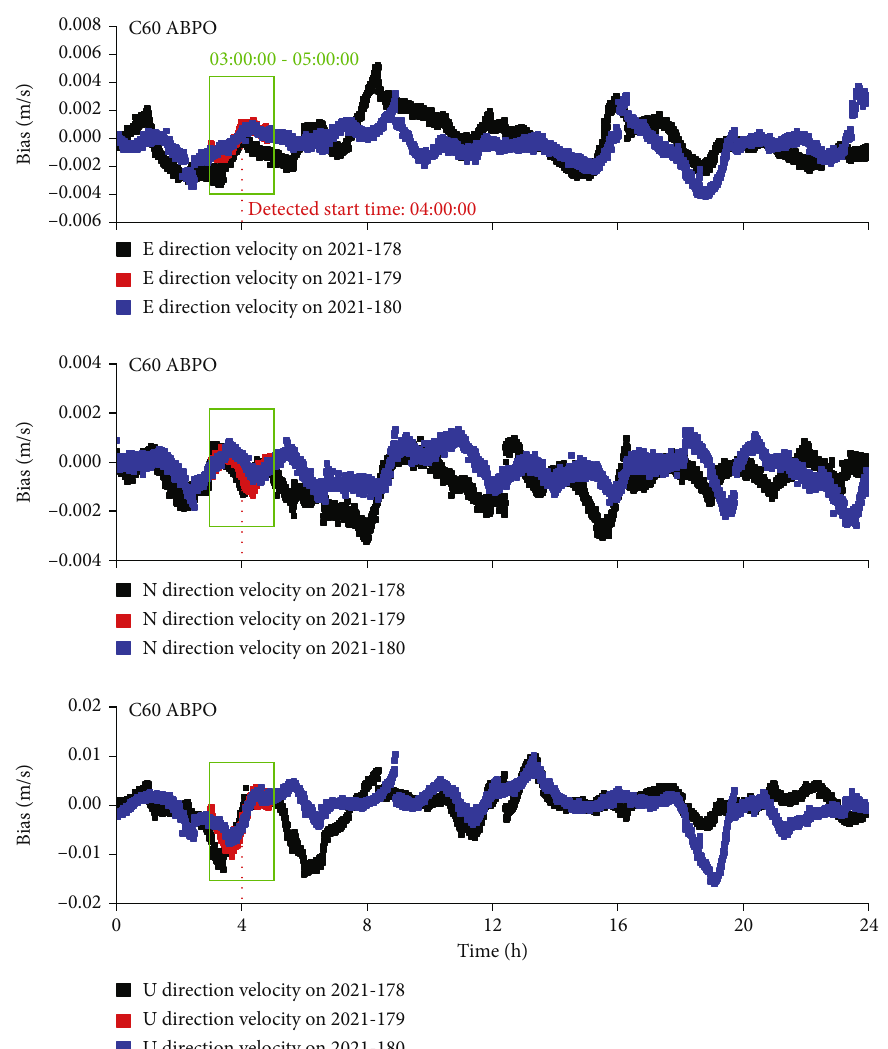
Figure 10: Comparison of the station velocity one hour before and after the detected maneuver start time (green box) with the station velocity when no maneuver